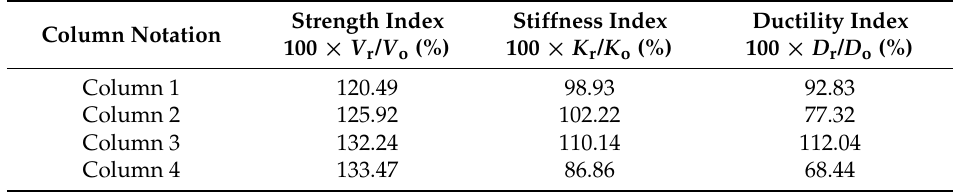
Table 4. Response indices for the repaired